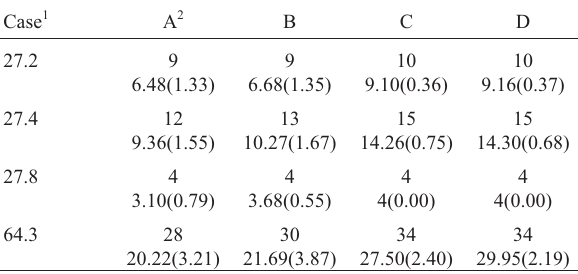
Table 1 - Original HP model: Performance comparison for variations on the standard GA * A: standard with two-point crossover. B: standard with multiple-points crossover (mp crossover). C: GA with new selection scheme and mp crossover. D: islands’ GA with new selection scheme